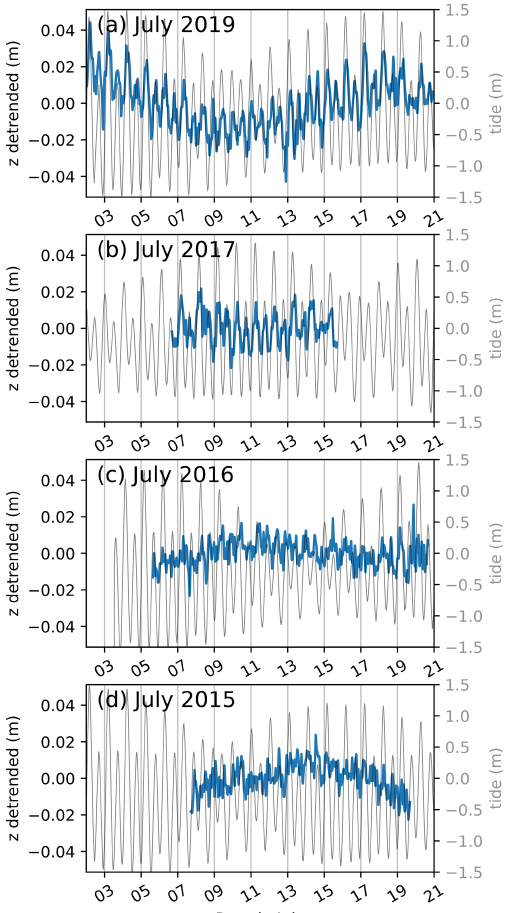
Figure 5. Detrended, 1h moving average vertical position (blue) at the station installed in each field campaign (location shown by blue dot in Fig. 3), with the tidal height in the background